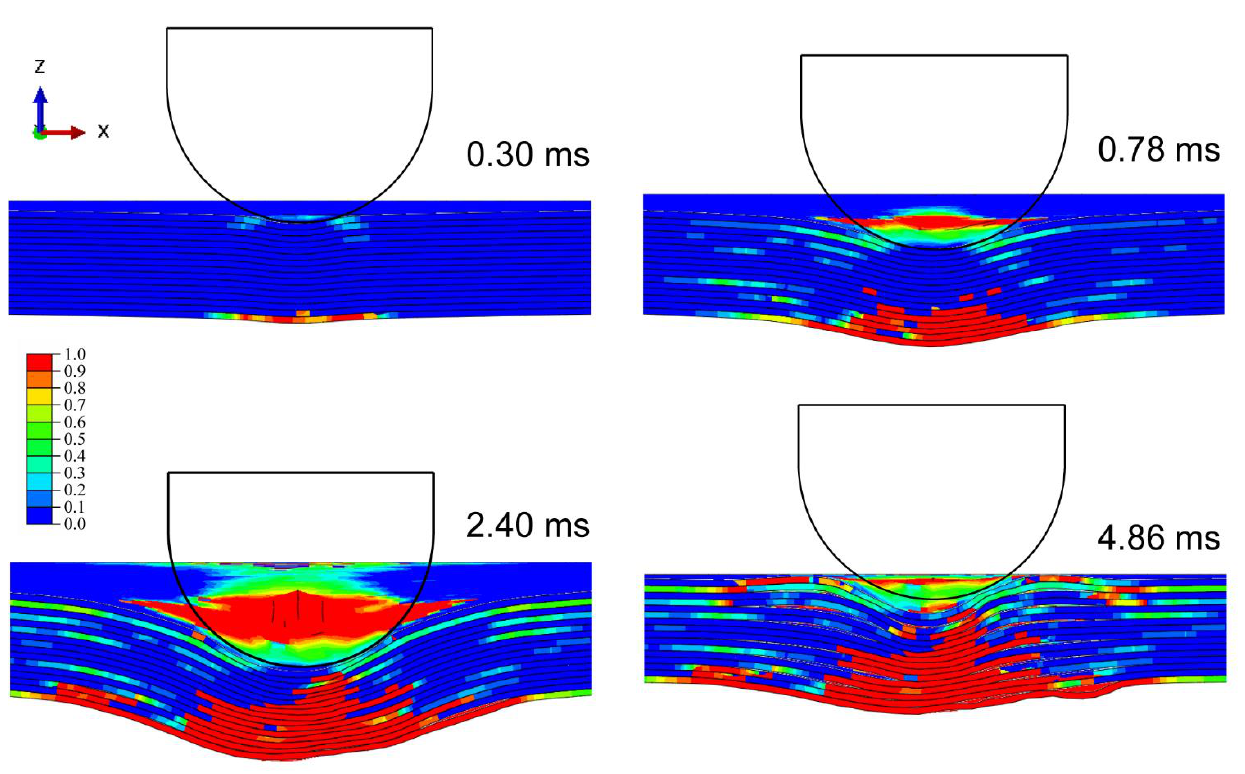
Figure 6. Evolution of matrix tensile damage with 0 ◦ impact angles under 20 J impact energy.